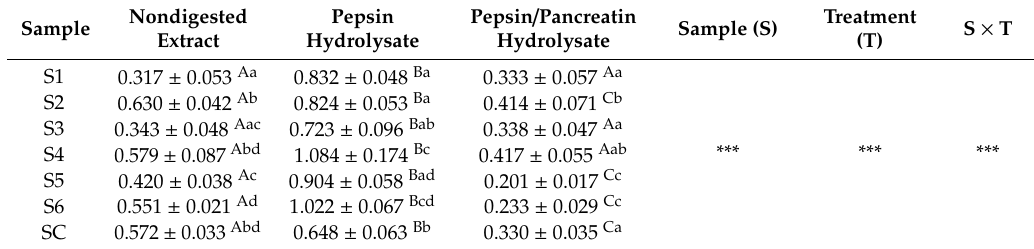
Table 6. Results of reducing power ( A 700 ).